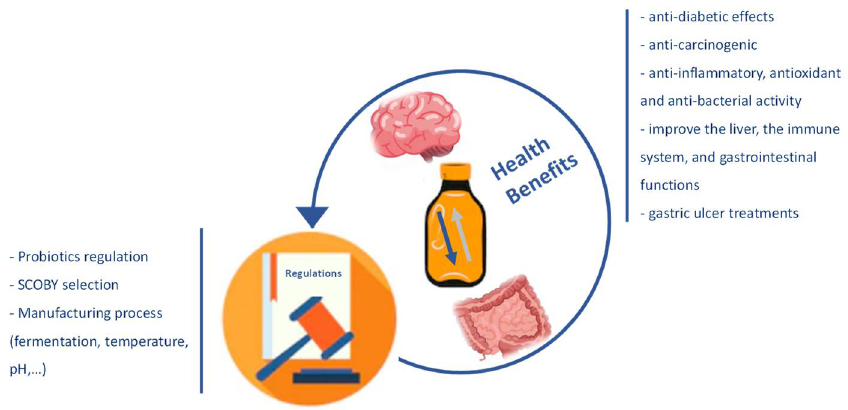
Figure 1. Description of the Kombucha’s health benefits and parameters lacking clear regulation worldwide.